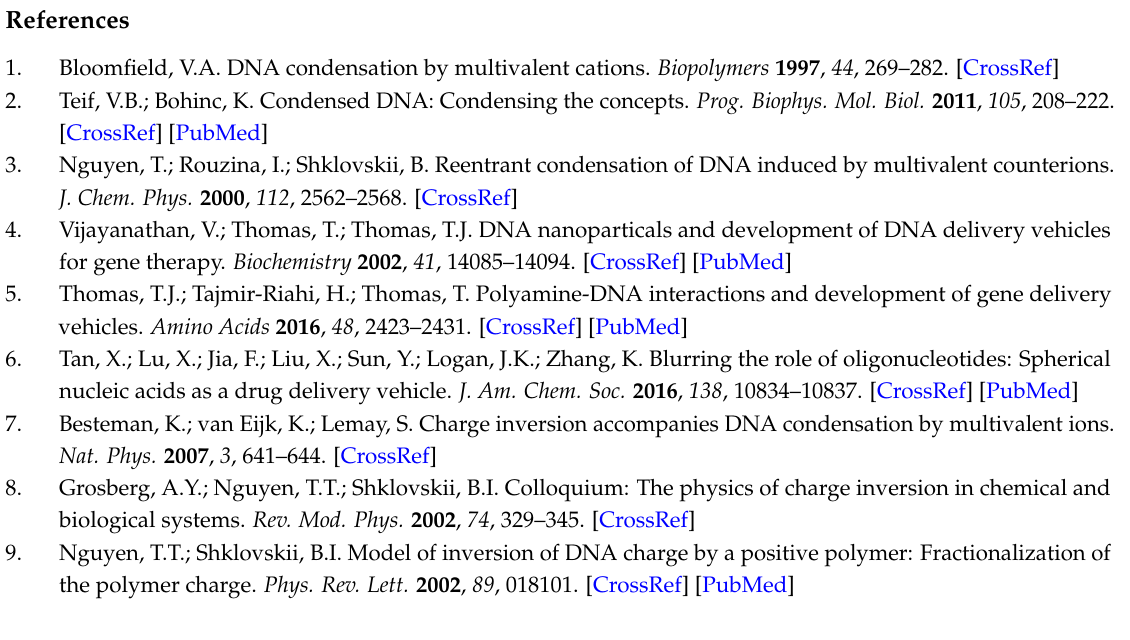
Table S1: The condensing force of DNA at different concentrations of Ph 4 As + , Table S2: The unravelling force of DNA at different concentrations of Ph 4 As + , Table S3: The particle size of DNA at different concentrations of Ph 4 As +